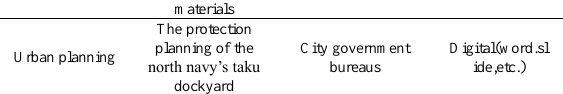
Table 1. Heritage data collected for documentation